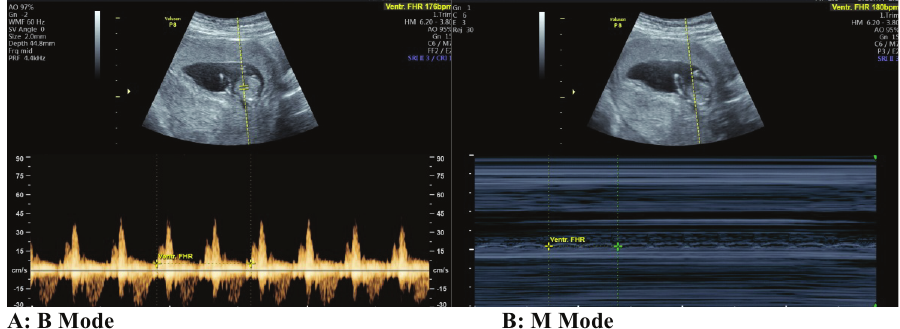
Figure 1 : Fetal heart rate measurement methods.